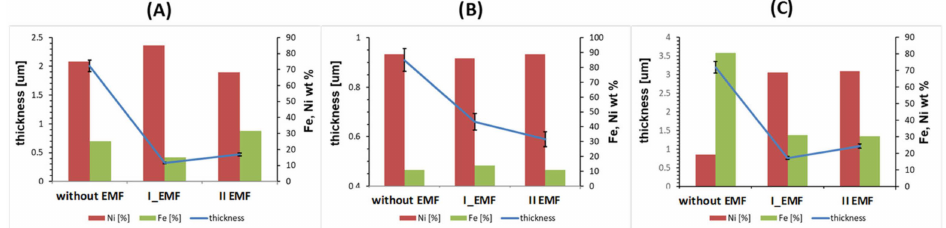
Figure 5. EMF influence on the Fe and Ni content in the FeNi alloy (blocks, right side) and on its thickness (line, left side); substrates: ( A ) brass, ( B ) silver, ( C ) aluminum, current density 50.0 mA/cm 2 , time of deposition—3600